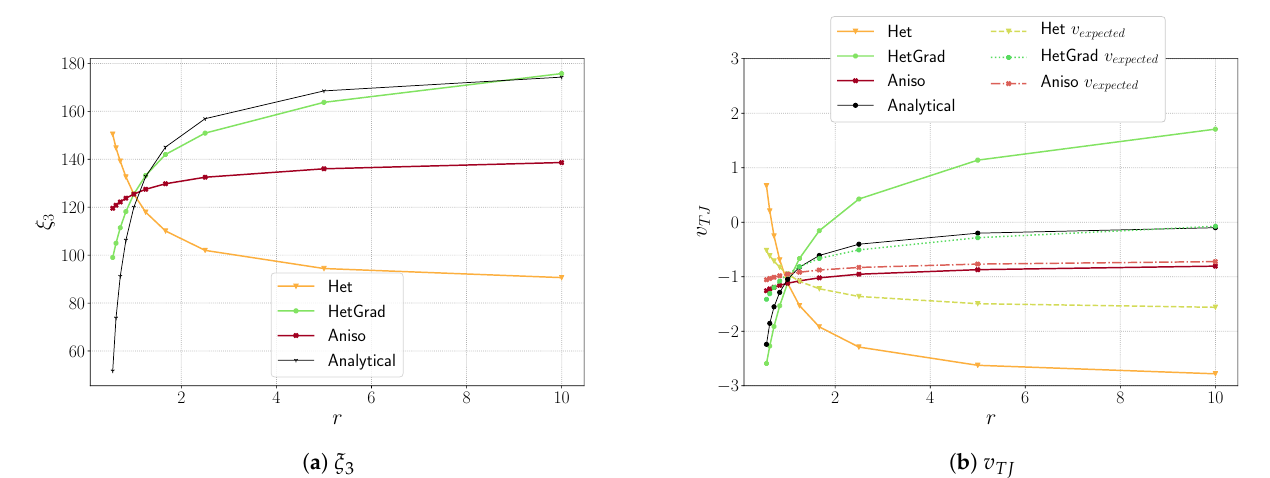
Figure 10. Variation of triple junction characteristics as a function of r using the Het, HetGrad, and Aniso formulations, and the 1 3 domain. h = 1 10 − 3 and ∆ t = 1 10 − 4 × × ×